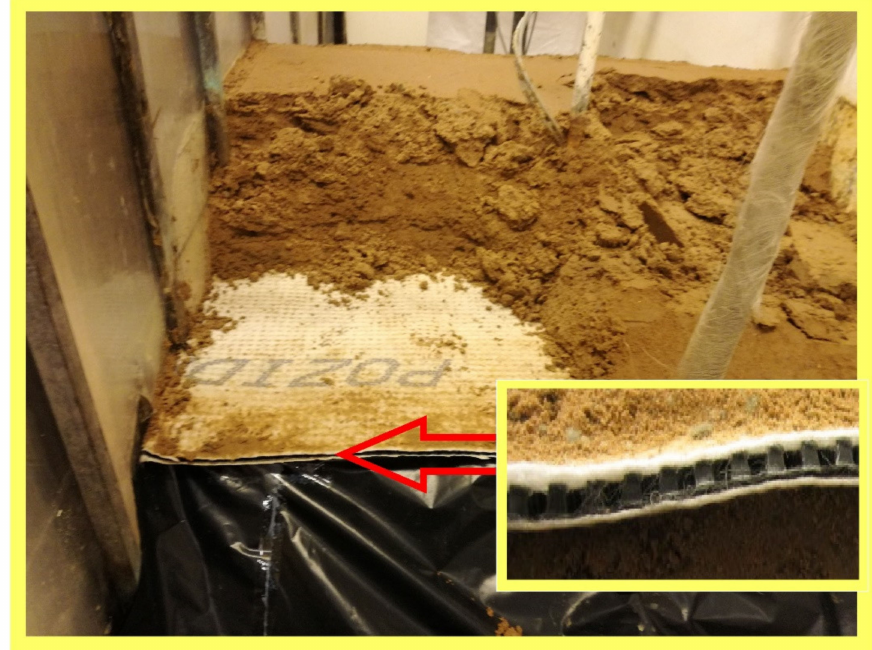
Figure 1. Drainage geocomposite with spatial structure in the form of an embossed